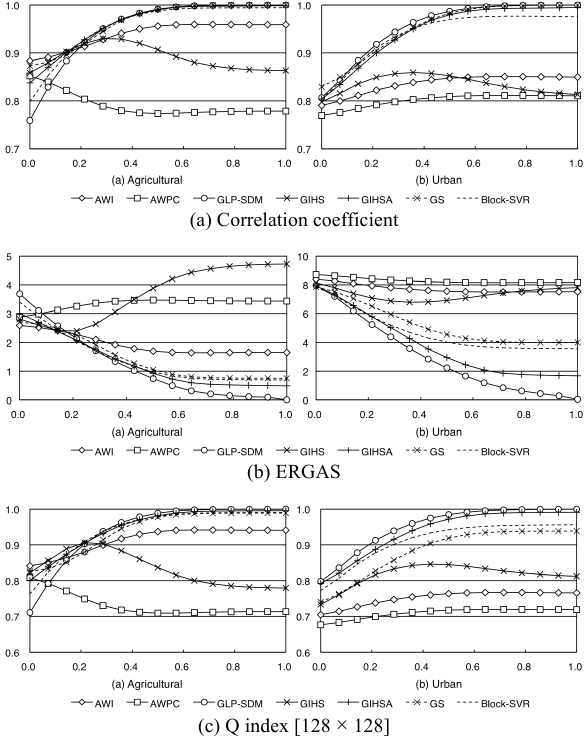
Figure 6. Correlation coefficient, ERGAS, and Q index of the NIR band for different rates of overlap of the PAN